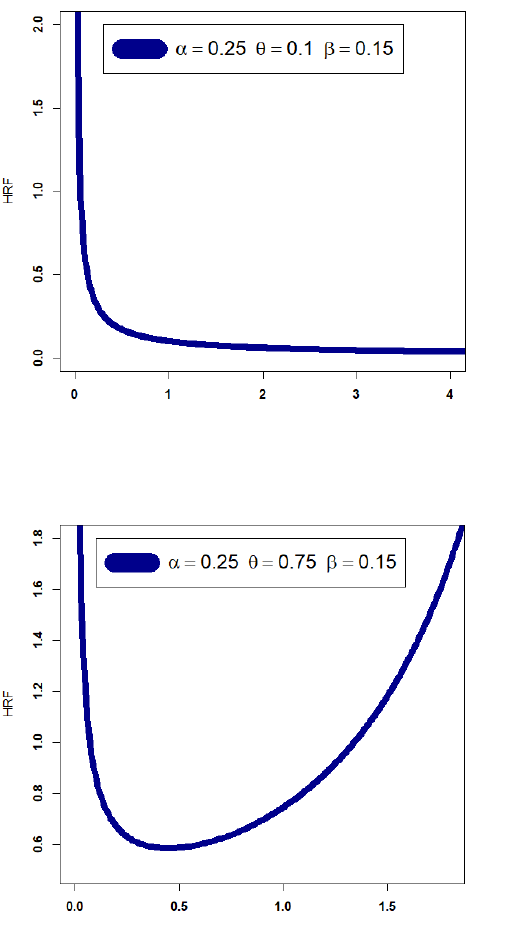
Figure 2. Some HRF